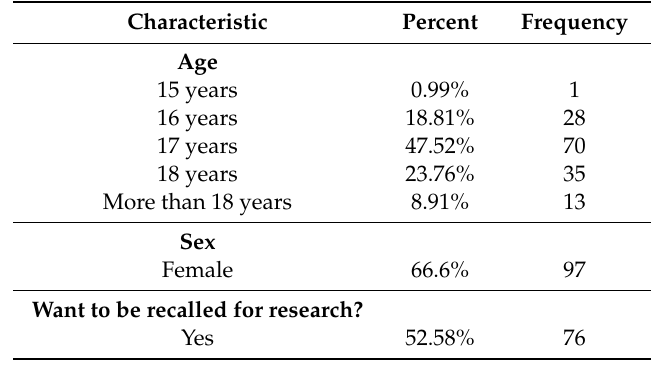
Table 4. Characteristics of the 147 who answered the ex-post survey after having being involved in